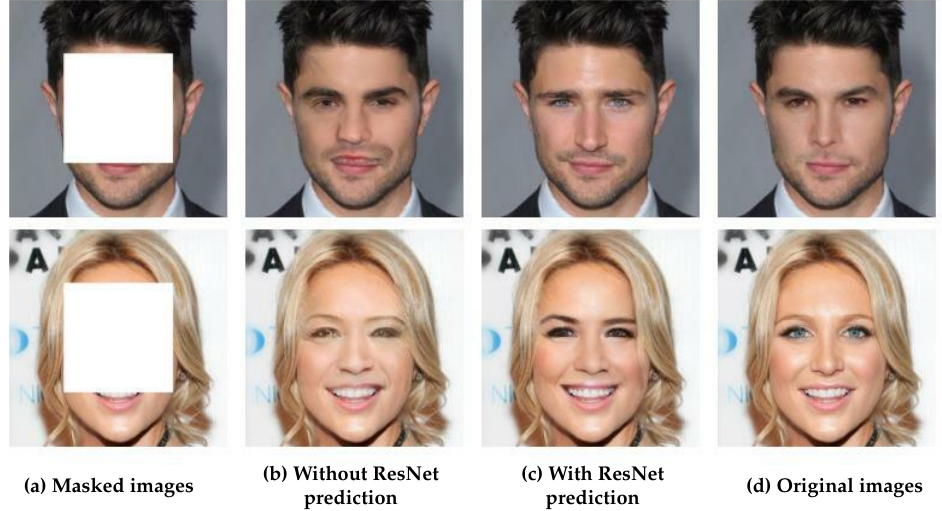
Figure 3. Comparison of completion results with or without ResNet